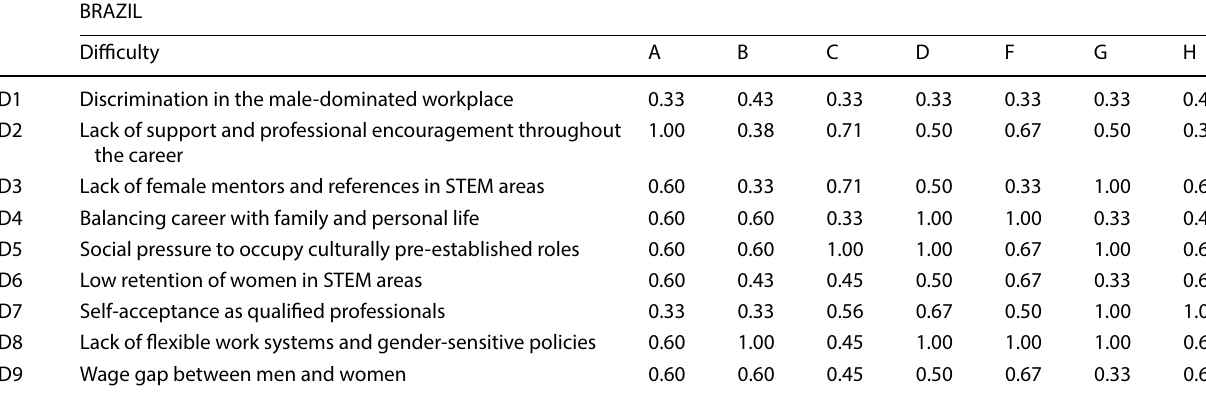
Table 5 Grey relational coefficients of the analysis of scores assigned for Brazil